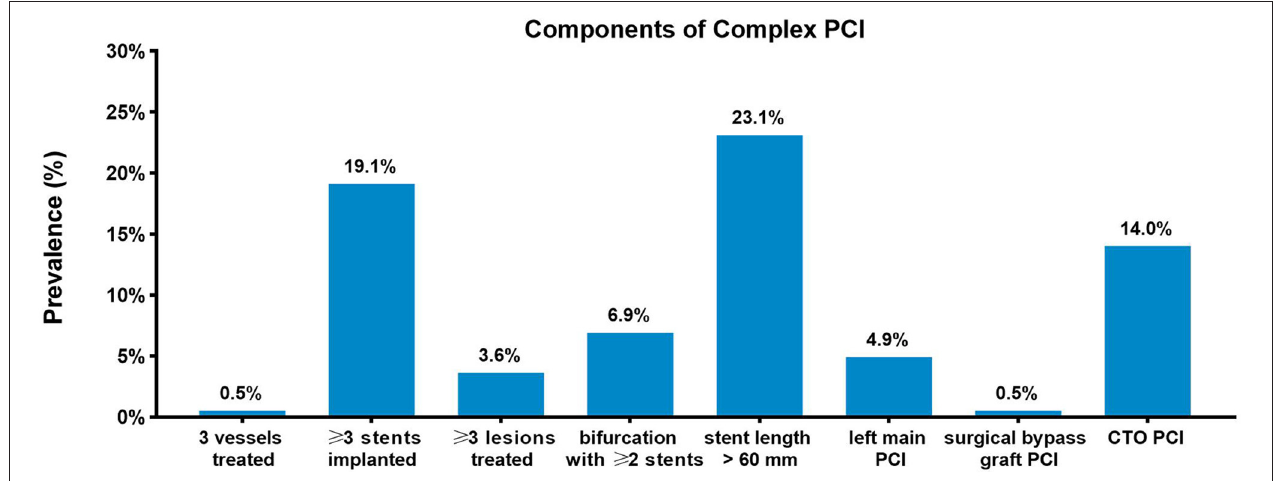
FIGURE 1 | Prevalence of complex percutaneous coronary intervention components. Prevalence of each complex percutaneous coronary intervention (PCI) component in the study population.